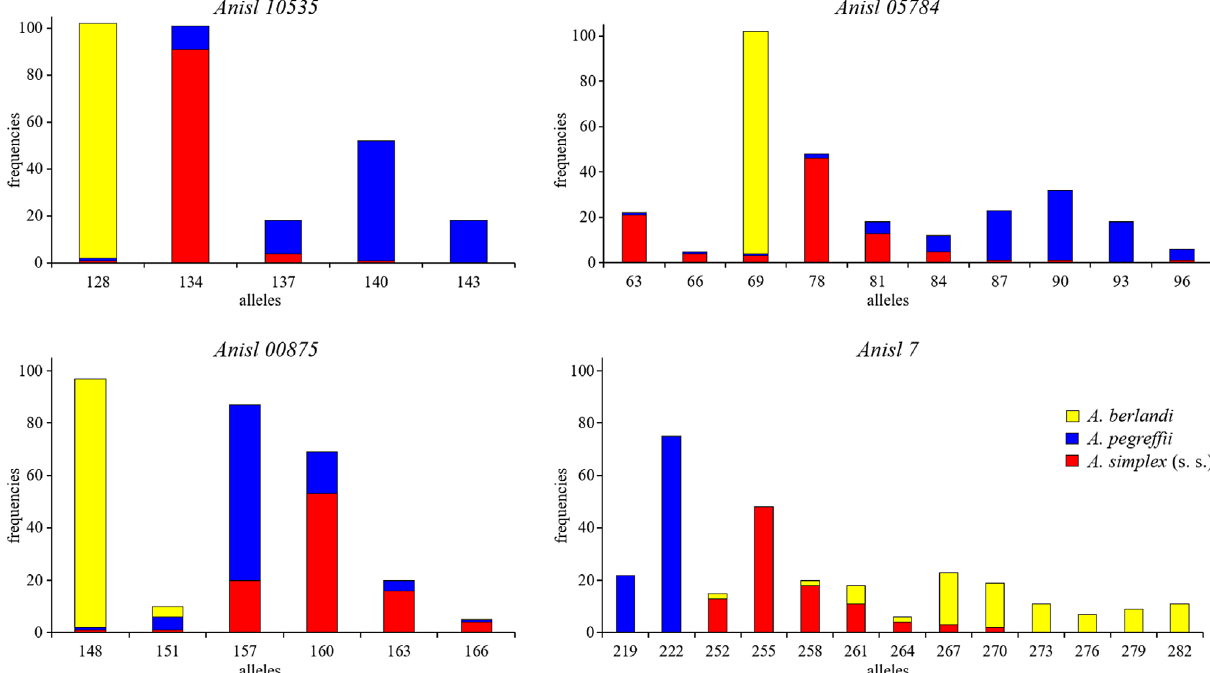
Figure 2. Distribution of allele frequencies of microsatellite loci in A. berlandi (yellow colour) shown for the partially diagnostic loci, with respect to the species A. pegref fi i (blue colour) and A. simplex (s. s.) (red colour) (see Table 3). Alleles showing a frequency (cid:5) 0.03 in the three Anisakis spp. were not included in the graphical representation, except in cased where they occurred in common with one or in the other two Anisakis species at a frequency (cid:6) 0.03 (see Table